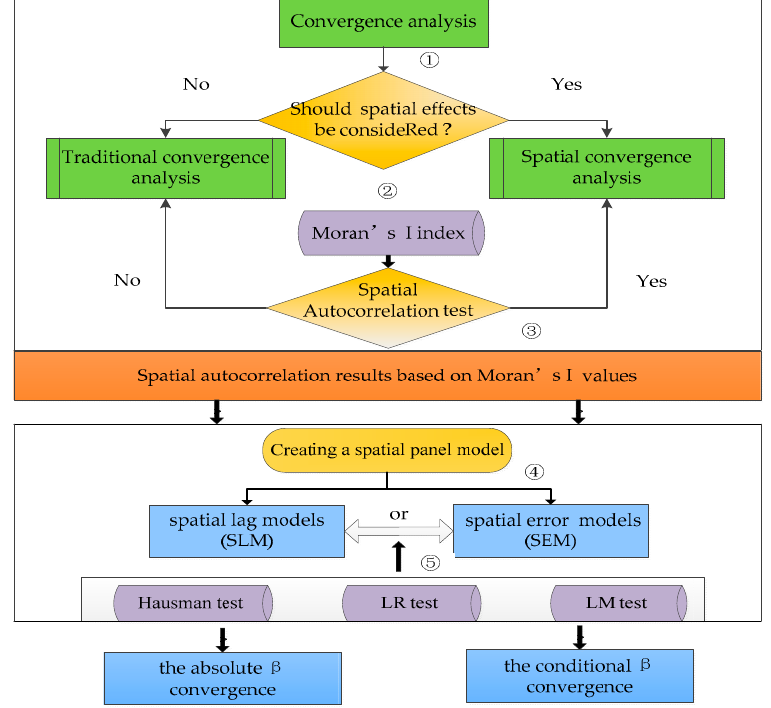
Figure 8. The process of convergence analysis.